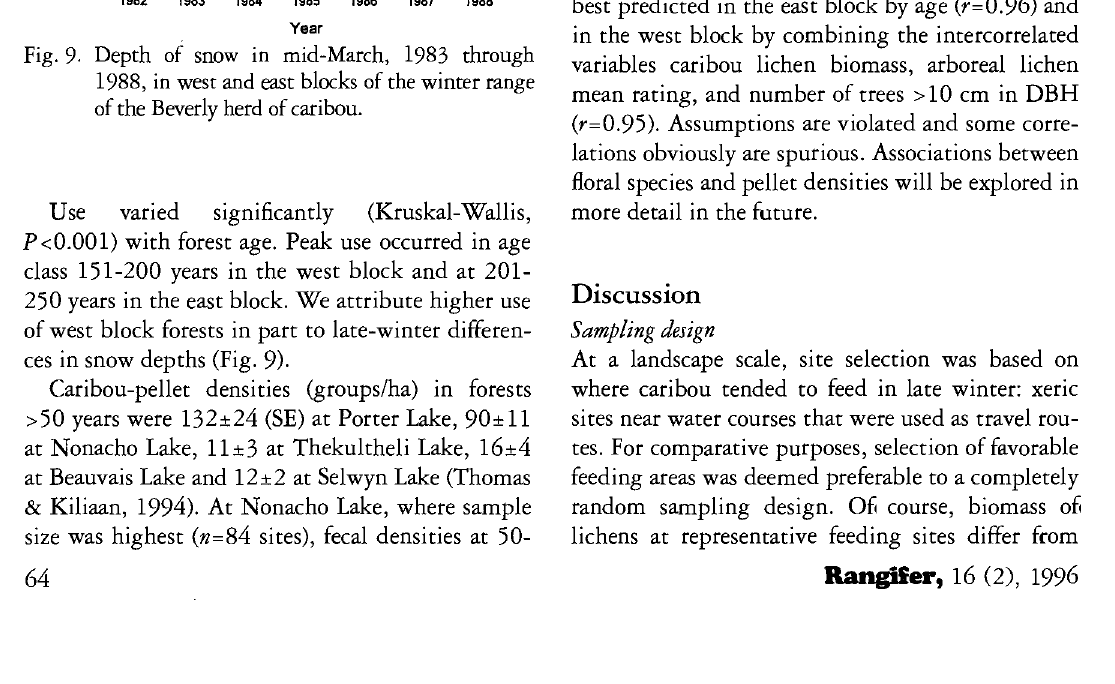
Fig. 9- Depth of snow in mid-March, 1983 through 1988, in west and east blocks of the winter range of the Beverly herd of